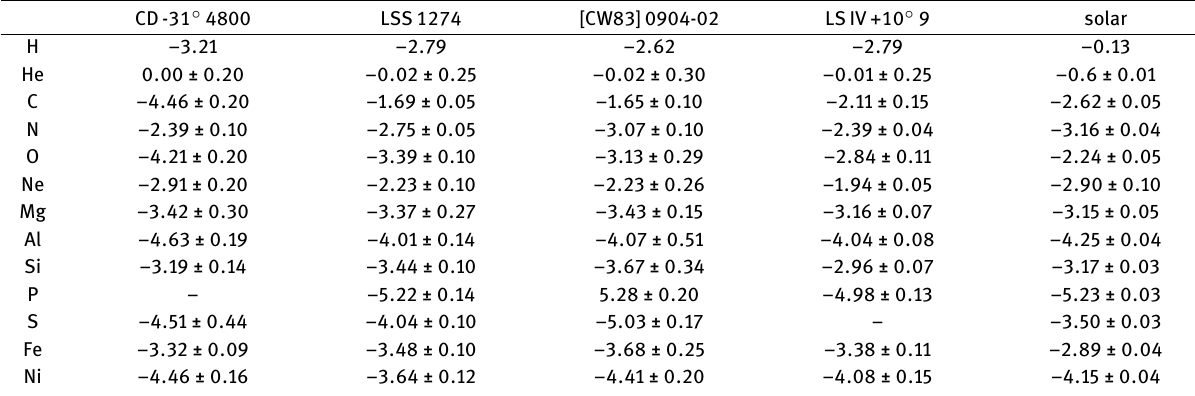
Table 3. Logarithmic surface mass abundances of the analyzed elements. Hydrogen was the reference element in the calculations of the model atmospheres, no errors are given for hydrogen. The last column gives the solar mass abundances taken from (Asplund et al. 2009) as a